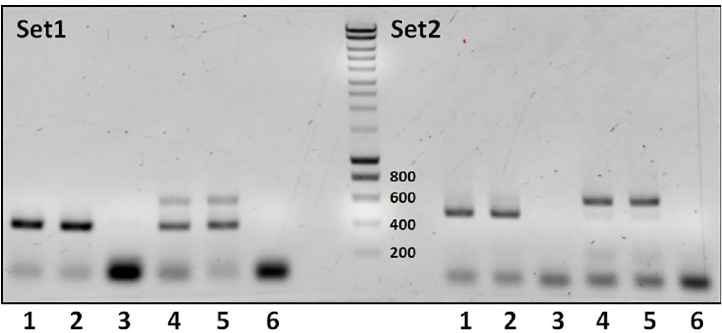
Fig 3. PCR analysis of samples taken directly from parasite lesions and in a distance of 1 cm to lesions. In lanes 1 and 2, samples had been taken directly from liver lesions, in samples 4 and 5 in 1 cm distance. Lanes 3 and 6 are negative controls. M indicates DNA marker lane. Set1 (left panel) has been performed with primer-set 1 (expected band size 374 bp), Set2 (right panel) was performed with primer-set 2 (expected band size 493 bp). PCR products have been separated on a 1.5% agarose gel and stained with ethidium bromide. DNA marker sizes (in bp) are indicated to the right of the marker